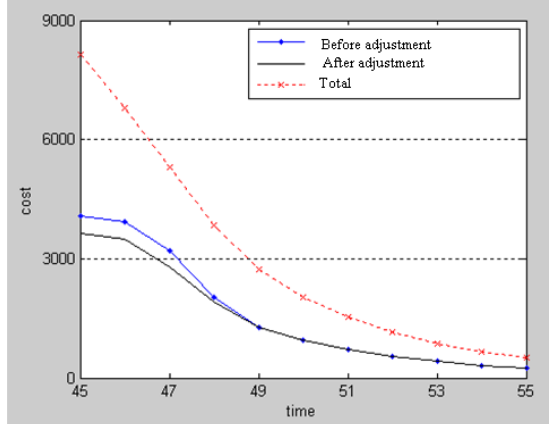
Figure 5. Total rescue cost at each rescue